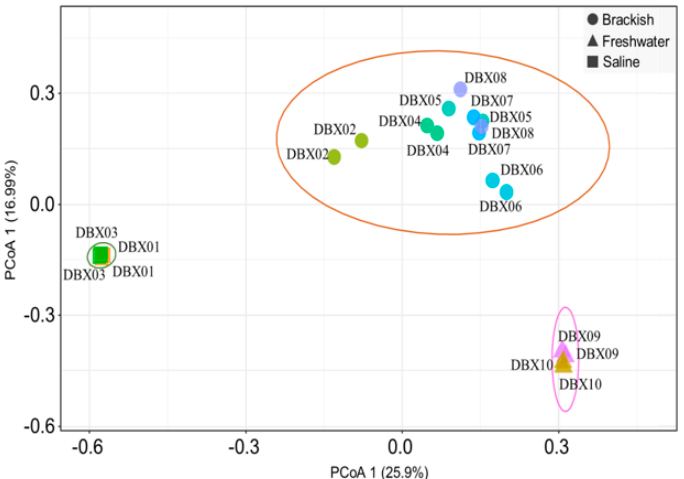
Figure 3. Results of the principal co-ordinate analysis showing differences in the eukaryotic phyto- plankton community between different samples based on the distance matrix.